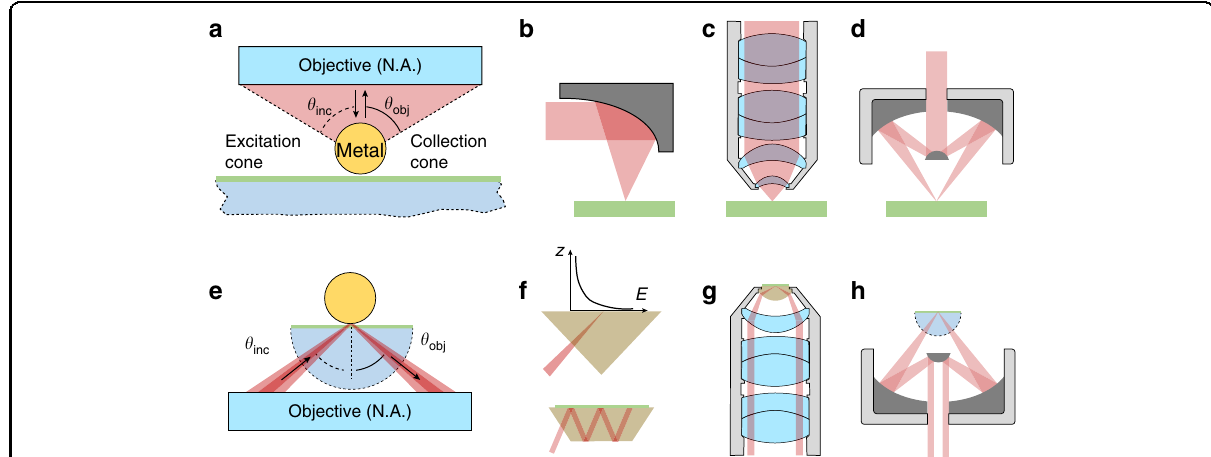
Fig. 8 Excitation and collection optics for SERS and SEIRA. a Traditional excitation and collection cone for SERS and SEIRA. b Re fl ective focus mirror, c traditional refractive, and d re fl ective objectives to excite and collect SERS and SEIRA. e Fine designed excitation and collection hollow cone for SERS and SEIRA. f Prism and waveguide-based excitation optics, g prism integrated refractive, and h re fl ective objectives to excite and collect SERS and SEIRA